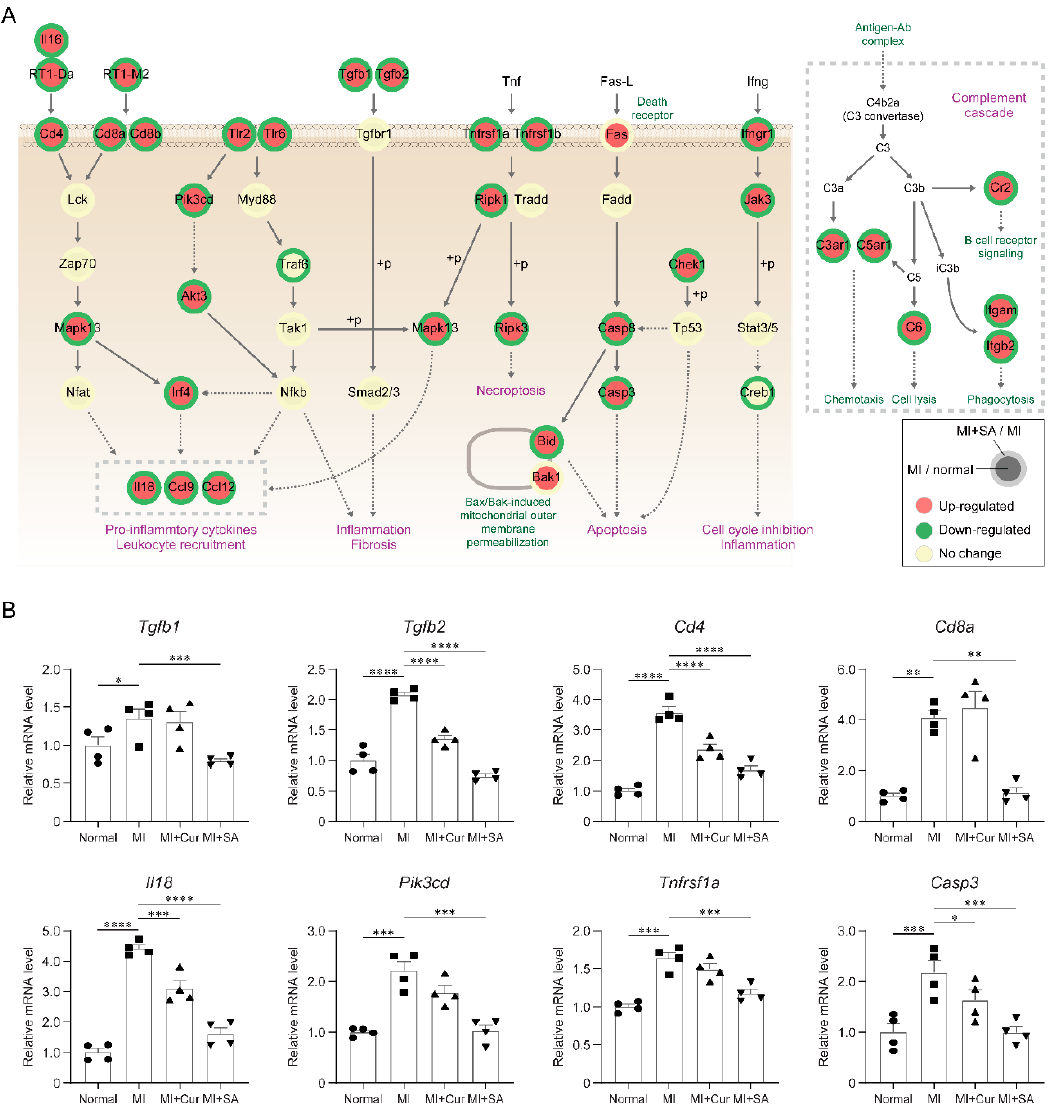
Figure 5. Inhibitory effects of Sappanone A administration on the MI-related processes. ( A ) Network model describing interactions among signaling pathways. Arrows, activation in signaling. “+p”, phosphorylation. ( B ) Confirmation of the predominant downregulation of the eight representative genes involved in the inflammatory responses and apoptosis by RT-PCR. The expression levels were normalized with respect to those in the control group. The normalized data are expressed as the mean ± SEM ( n = 4 per group). * p < 0.05, ** p < 0.01, *** p < 0.001, **** p < 0.0001 by two-way ANOVA tests with Tukey’s post hoc correction.